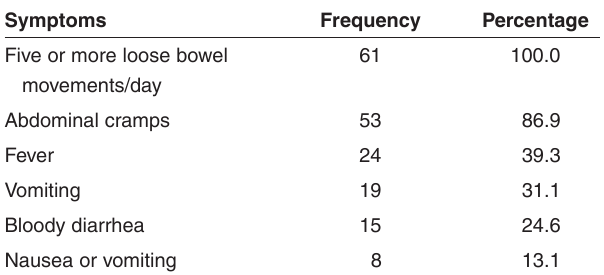
TABLE 2 Case symptoms in case control study of patients with Escherichia coli 0157:H7, Middlesex-London, Ontario,